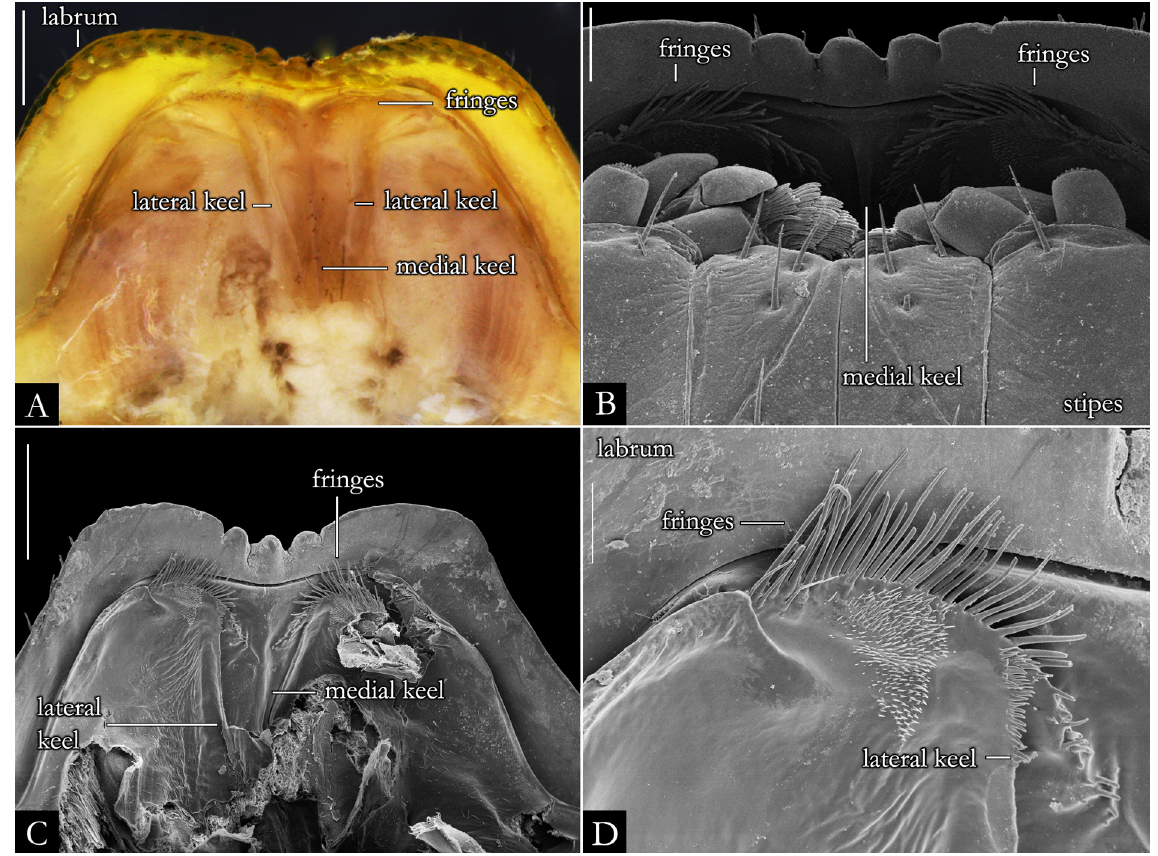
Fig. 23. SEM and stereoscopic images of epipharynx Pseudonannolene robsoni Iniesta & Ferreira, 2014. A . Ventral view (IBSP 3526). B . Ventral view (IBSP 3506). C–D . Ventral view (IBSP 3504). Scale bars: A, C = 0.5 mm; B = 0.2 mm; D = 1